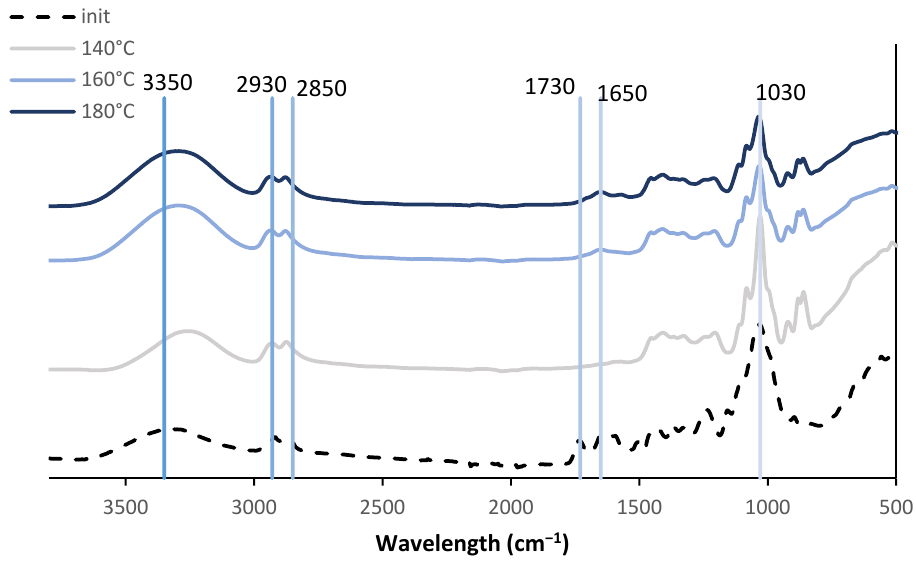
Figure 6. FTIR spectra of the initial material and the liquefied polyol for a 60 min reaction at 140 °C, 160 °C and 180 °C with acid catalysis.